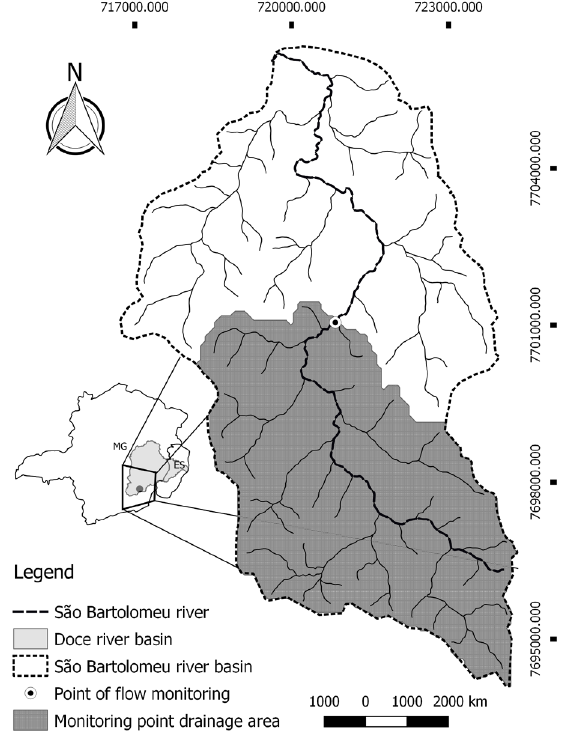
Figure 1. Location of São Bartolomeu river basin and gauge